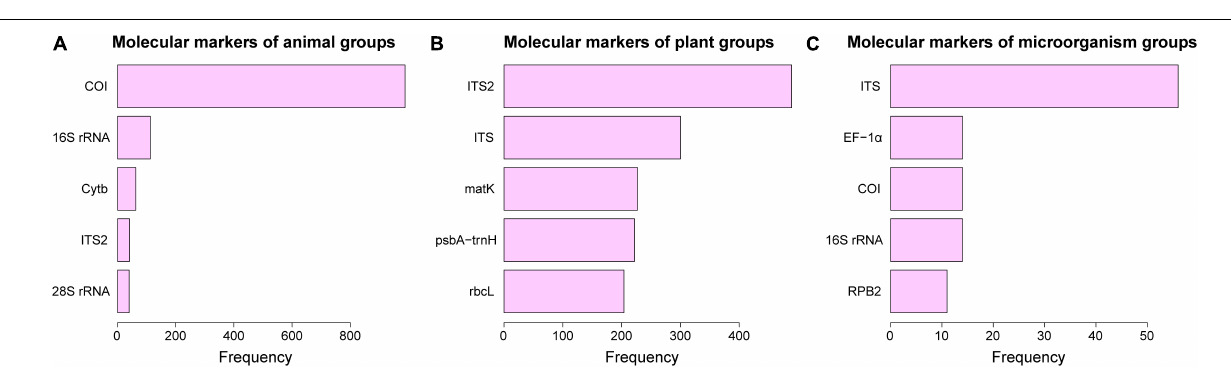
groups in China ( Figure 8A ), indicating that the COI